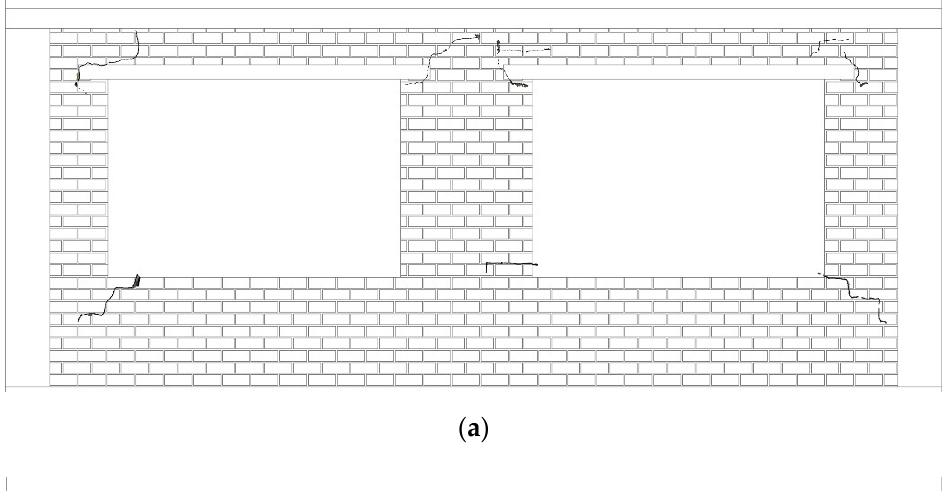
Figure 12. Cracks in the wall of the structure model of the GSI–RSM test.